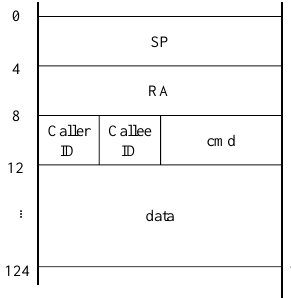
Figure 16: Structure of shared memory.